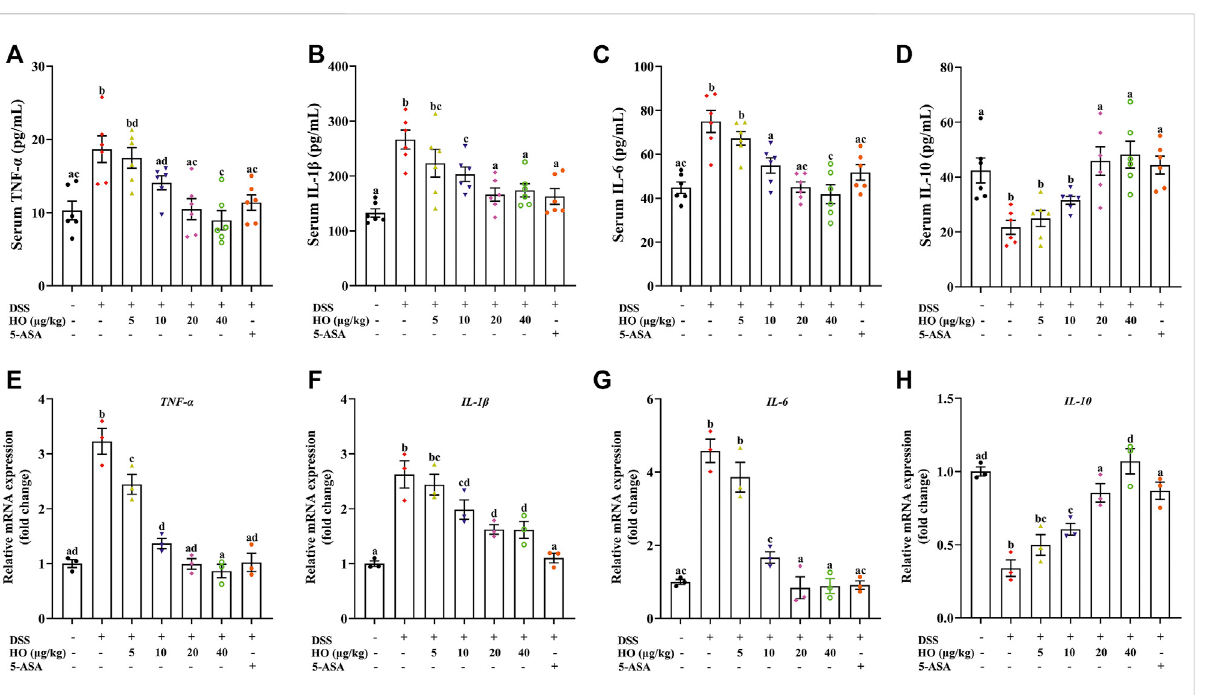
FIGURE 3 Effect ofHO onin fl ammatoryfactors intheserumandcolon inDSS-exposedmice. (A) SerumTNF- α level. (B) SerumIL-1 β level. (C) SerumIL-6 level. (D) Serum IL-10 level. Relative geneexpressions ofTNF- α (E) , IL-1 β (F) , IL-6 (G) , and IL-10 (H) inthecolon. Thelevelsofserum TNF- α ,IL-1 β , IL- 6, and IL-10 were detected by ELISA. Gene expression levels of these cytokines in the colon were analyzed by RT-qPCR. The data are expressed as mean ± S.E.M. ( n = 3 – 6). Bars with different letters represent signi fi cant differences between groups by Fish ’ s LSD test ( p <